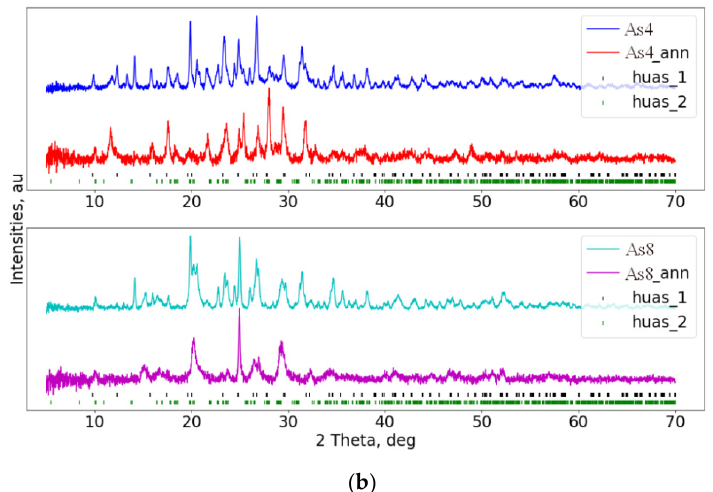
Figure 3. ( a ) PXRD patterns of the: As1 (90% Gm and 10% HUAs), As2 (80% Gm and 20% HUAs) and As6 (40% Gm and 60% HUAs) composites inset on an upper sub-figure shows reflection’s shift towards higher angles, indicating shrinkage of the material’s unit cell. ( b ) the As4 (54% Gm and 46% HUAs) and As8 (18% Gm and 82% HUAs) HUAs-based composites. Vertical bars show Bragg peak positions of the assigned crystallographic phases (see main text).